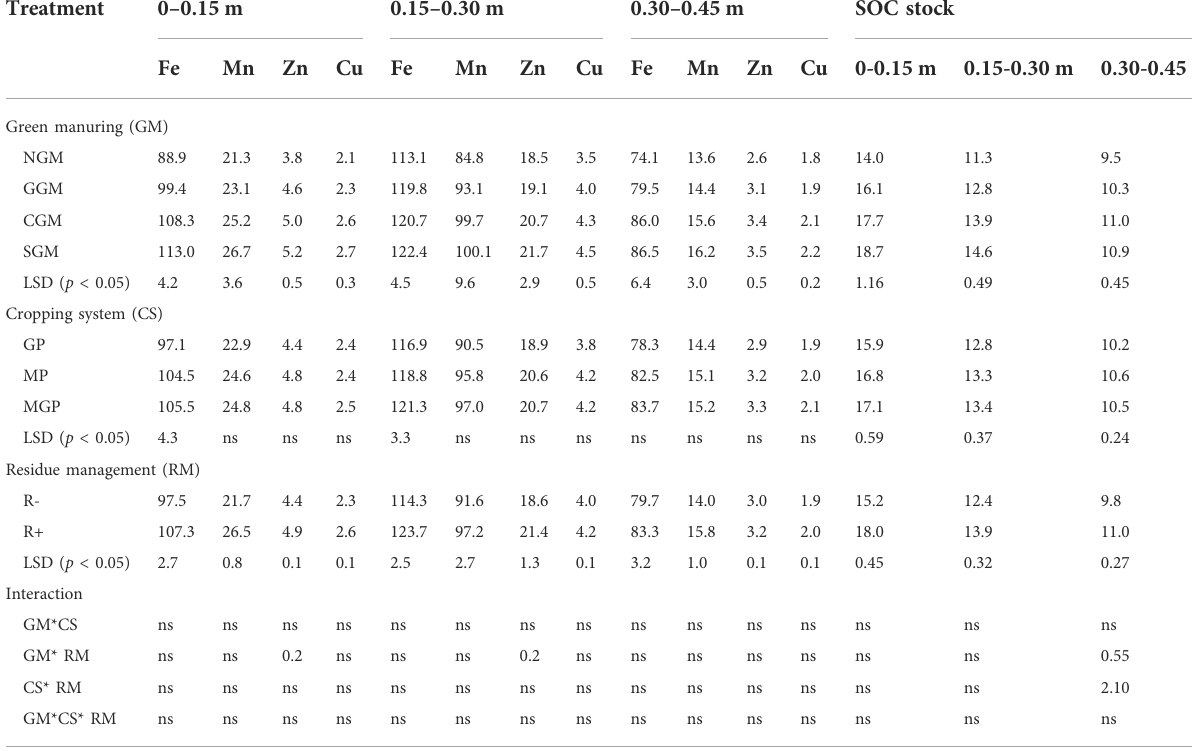
TABLE 3 Effect of green manuring, cropping systems, and residue management on micronutrients and soil organic C storage in different soil depths after 5 years of experimentation.